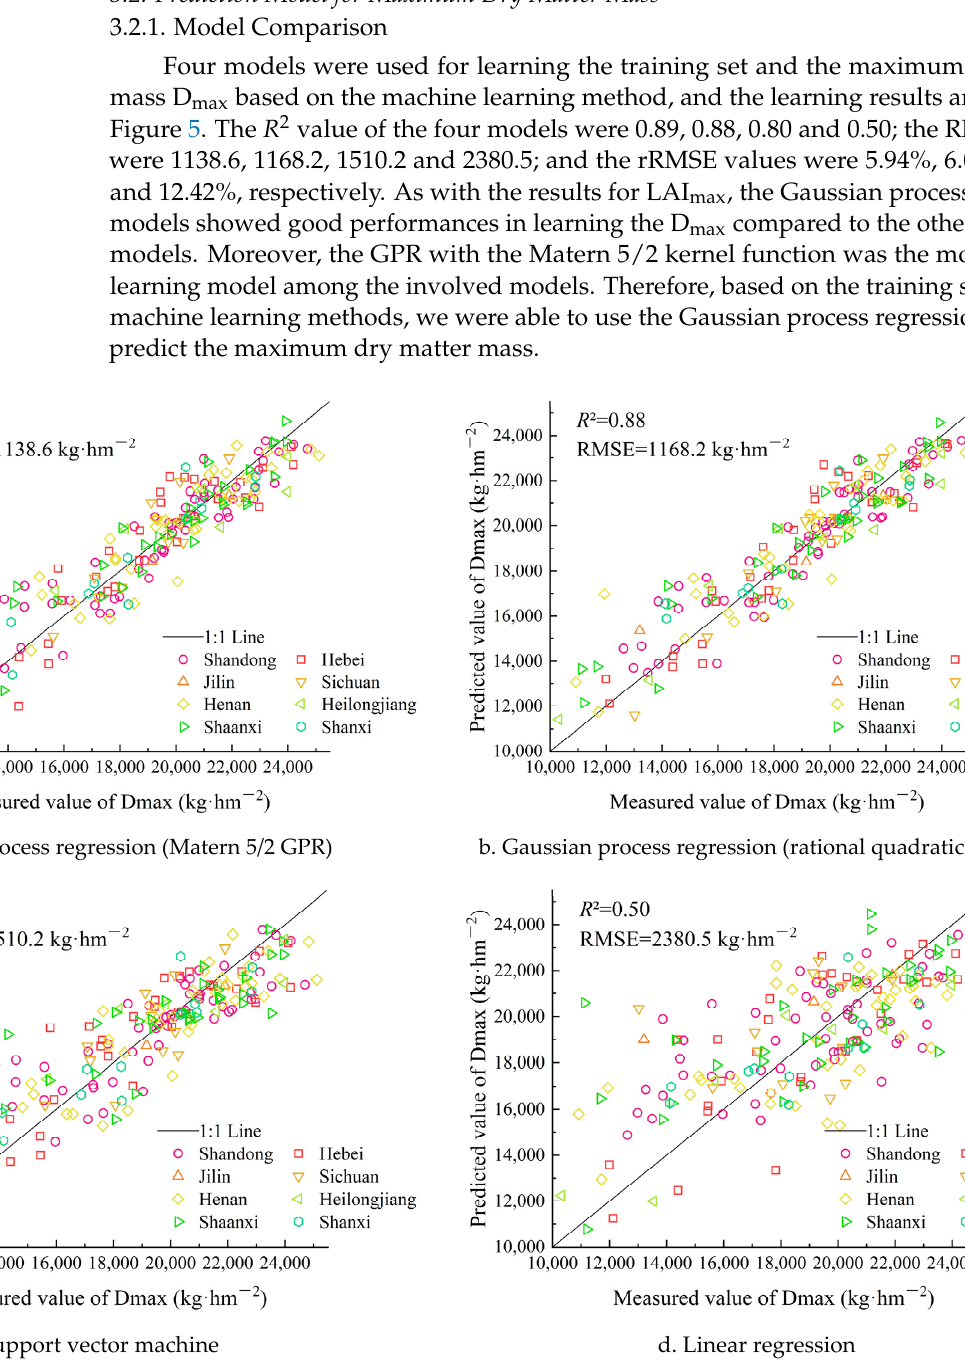
Figure 4. Fitting results for LAI max with the quadratic polynomial based on the values predicted by Gaussian regression model.